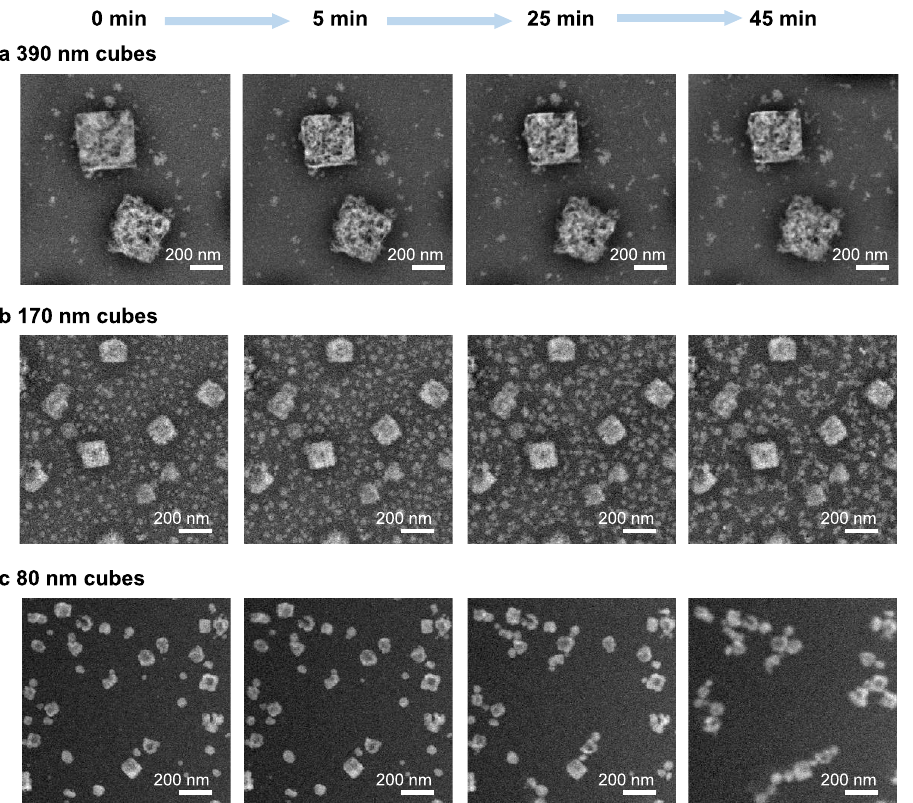
Fig. 2 Morphological evolution of Cu 2 O cubes and re-deposited NPs captured under operando conditions over 45 min of CO 2 RR by EC-TEM. Snapshots extracted from the videos tracking the evolution of a 390 nm, b 170 nm, and c 80 nm cubes at 0, 5, 25, and 45 min after applying a potential of − 0.9 V RHE . Each image is an average of 10 frames. The electron fl ux used is 3.5 e − Å − 2 s − 1